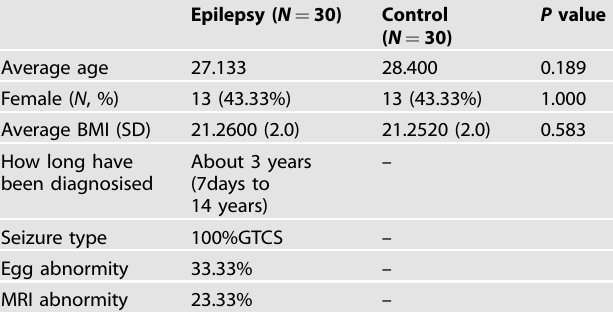
Table 1. The characteristics of the patients and controls.